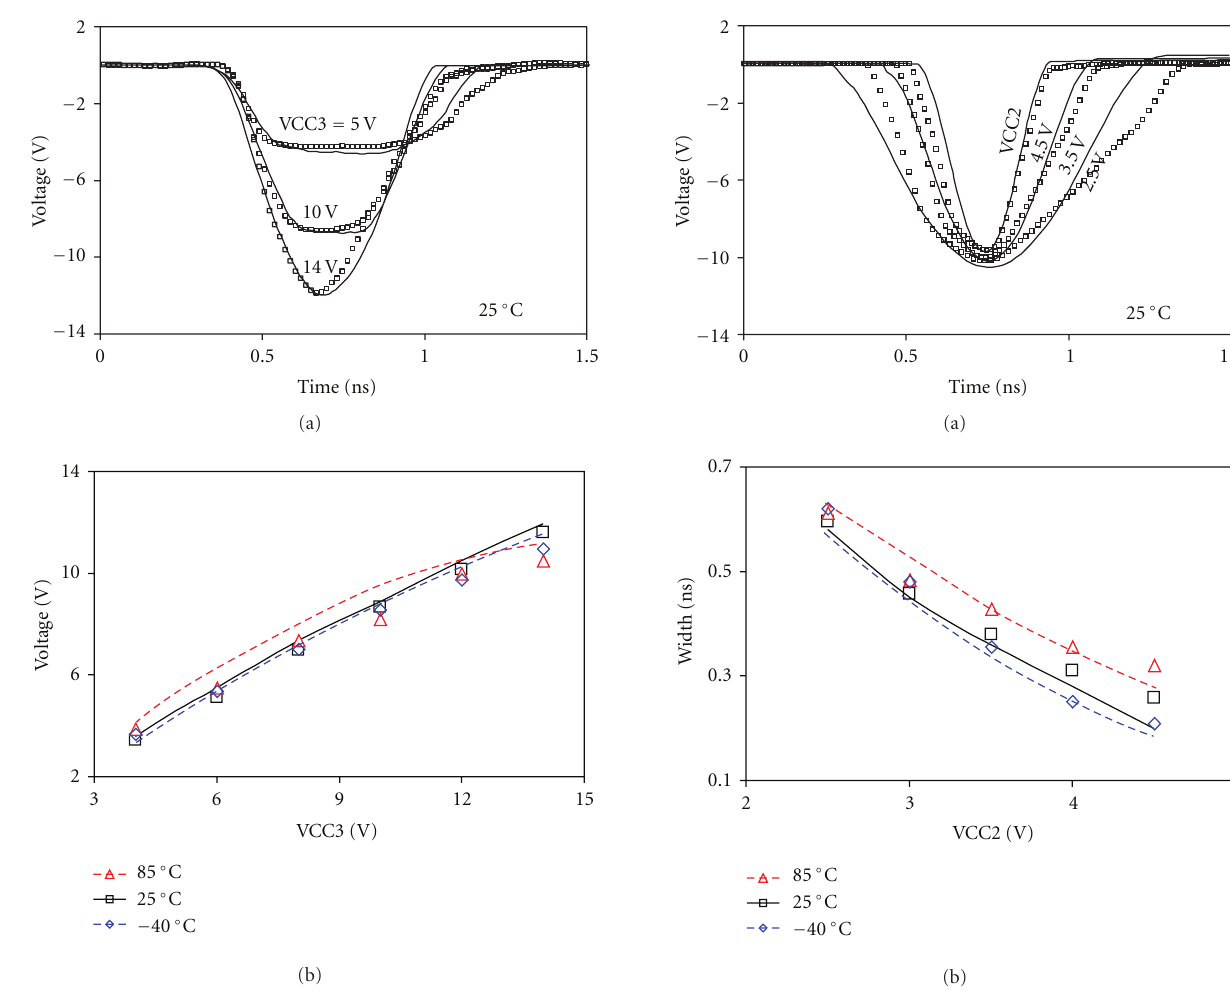
Figure 7: Measured (symbol) versus simulated (curve) (a) wave- form and (b) width of impulses at Node C of the pulse generator with VCC1 = 3.3 V, VCC2 = 2.5–4.5 V, and VCC3 = 12